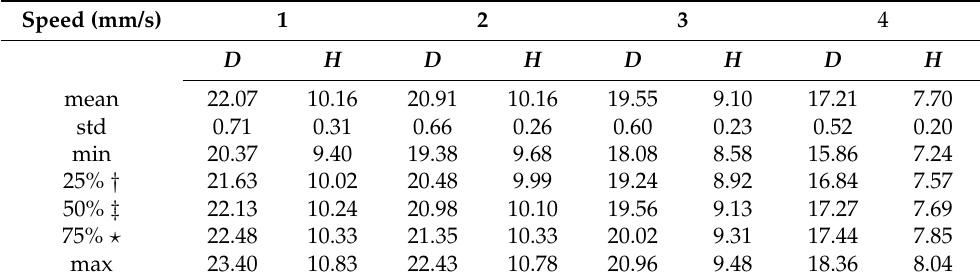
Figure 7. The typical profile of micro cavities at different nozzle moving speed: ( a ): 2mm/s; ( b ): 4mm/s; ( a 1 , b 1 ): SEM images of machined cavities; ( a 2 , b 2 ): Confocal laser scanning microscope images of machined cavities; ( a 3 , b 3 ): Cross-sectional images of corresponding machined cavities. Table 6. Diameter and depth of machined cavities with different nozzle moving